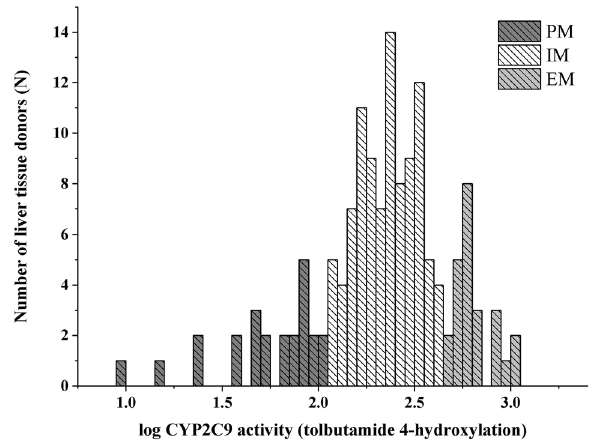
Figure 1. Frequency distribution of hepatic CYP2C9 activities (tolbutamide 4 ′ -hydroxylation) in human tissue